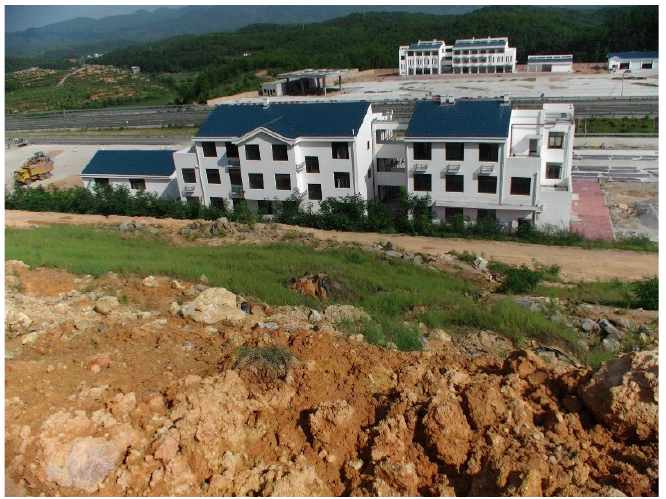
Figure 3. Study area background.